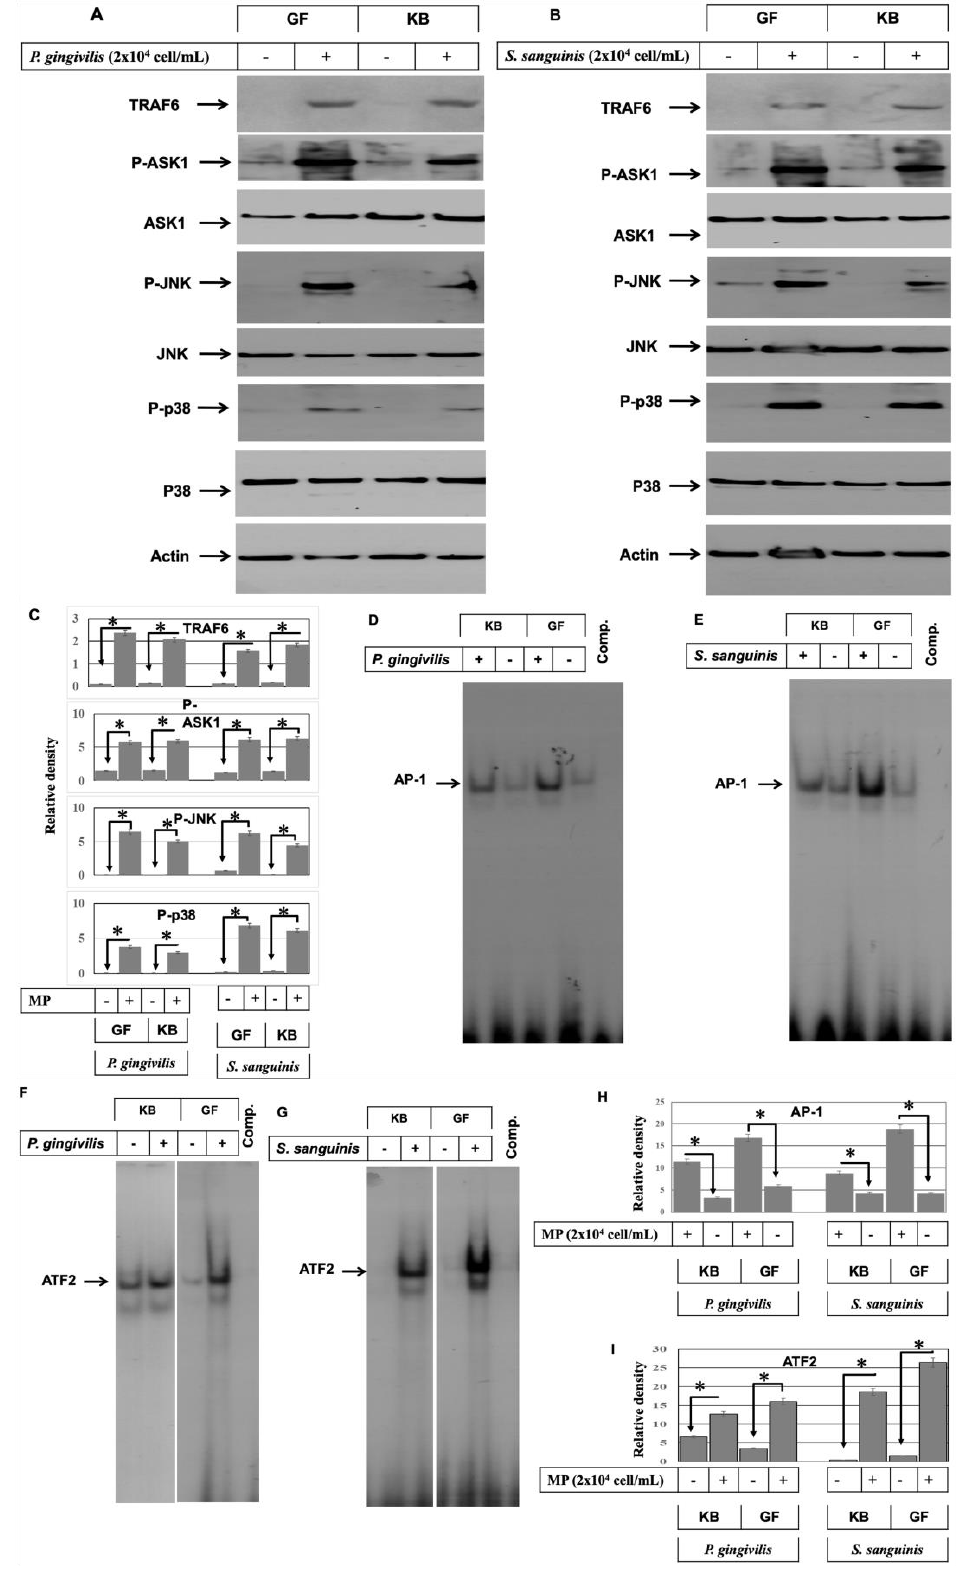
Figure 3. Induction of ASK1, JNK, and p38 pathways in oral mucosa by both gram − and gram + bacterial pathogens. Both GF and KB cells were stimulated with either heat-inactivated P. gingivalis (2 × 10 4 cells/mL) or S. sanguinis (2 × 10 4 cells/mL) microbial pathogens (MPs) for 48 h ( A , B ).